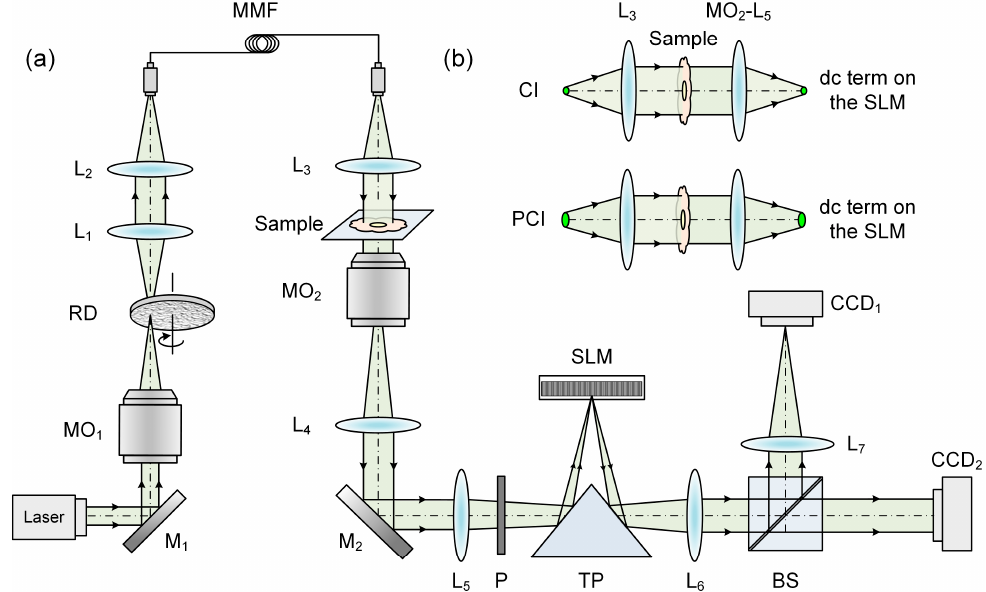
Figure 1. Schematic diagram of PCI-QPCM. ( a ) Experimental setup; ( b ) relation between the diam- eters of PCI emission, CI emission, and dc term on the SLM. BS, beam splitter; CCD 1 and CCD 2 , charge-coupled device; L 1 –L 7 , achromatic lens; M 1 and M 2 , mirrors; MMF, multi-mode fiber, MO 1 and MO 2 , microscopic objectives; P, polarizer; RD, rotating diffuser; SLM, spatial light modulator; TP, triangle prism.